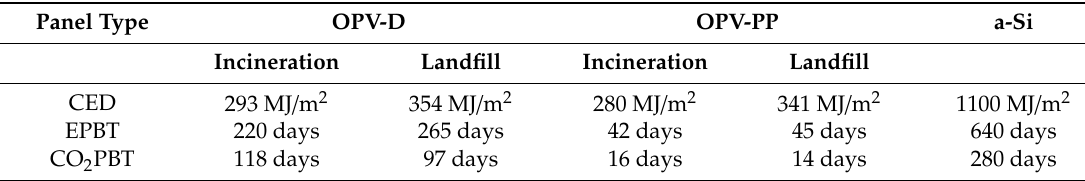
Table 13. Comparison between OPV (D and PP) and a-Si in scenario 2 [62]. Panel